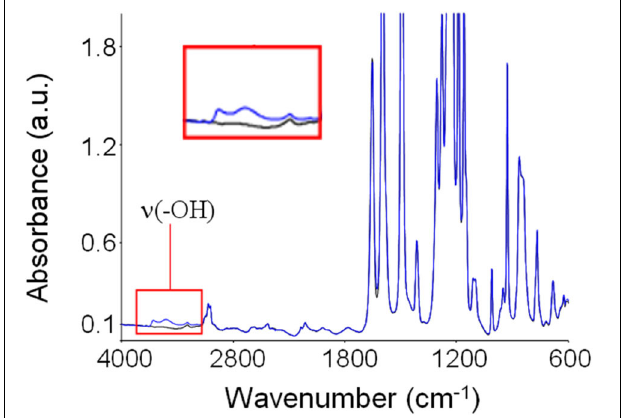
FIGURE 5 | Absorbance spectrum of dry PEEK (black trace) and of PEEK after equilibration with water vapor at 30 ◦ C and p / p 0 = 0 . 75 (blue trace). In the inset is reported an enlargement of the ν (-OH) band.